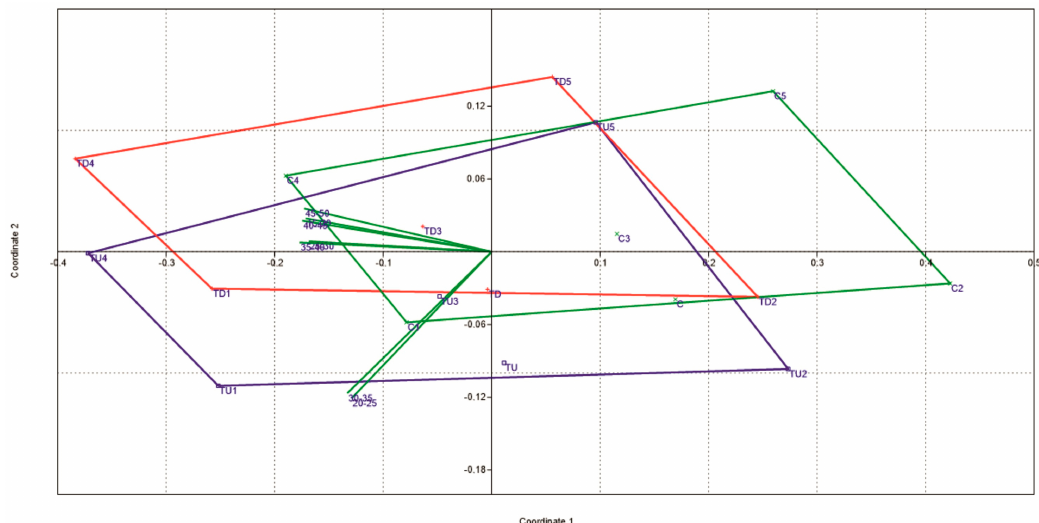
Figure 3. Non-metric multidimensional scaling (NMDS) of the average ring width per diameter class for the trees in the control area C (green polygon, N. = 5 plots, 7 diameter classes, 2 stem core samples = 70), for damaged trees TD (violet polygon, N. = 25 plots, 7 diameter classes, 1 stem core samples = 175), and for undamaged trees TU (red polygon, N. = 25 plots, 7 diameter classes, 1 stem core samples = 175) in the thinned area. The analysis is focused on a specific time period post thinning, from 1998 to 2008 (ten rings—TPT1). Forests 2018 , 9 , x FOR PEER REVIEW